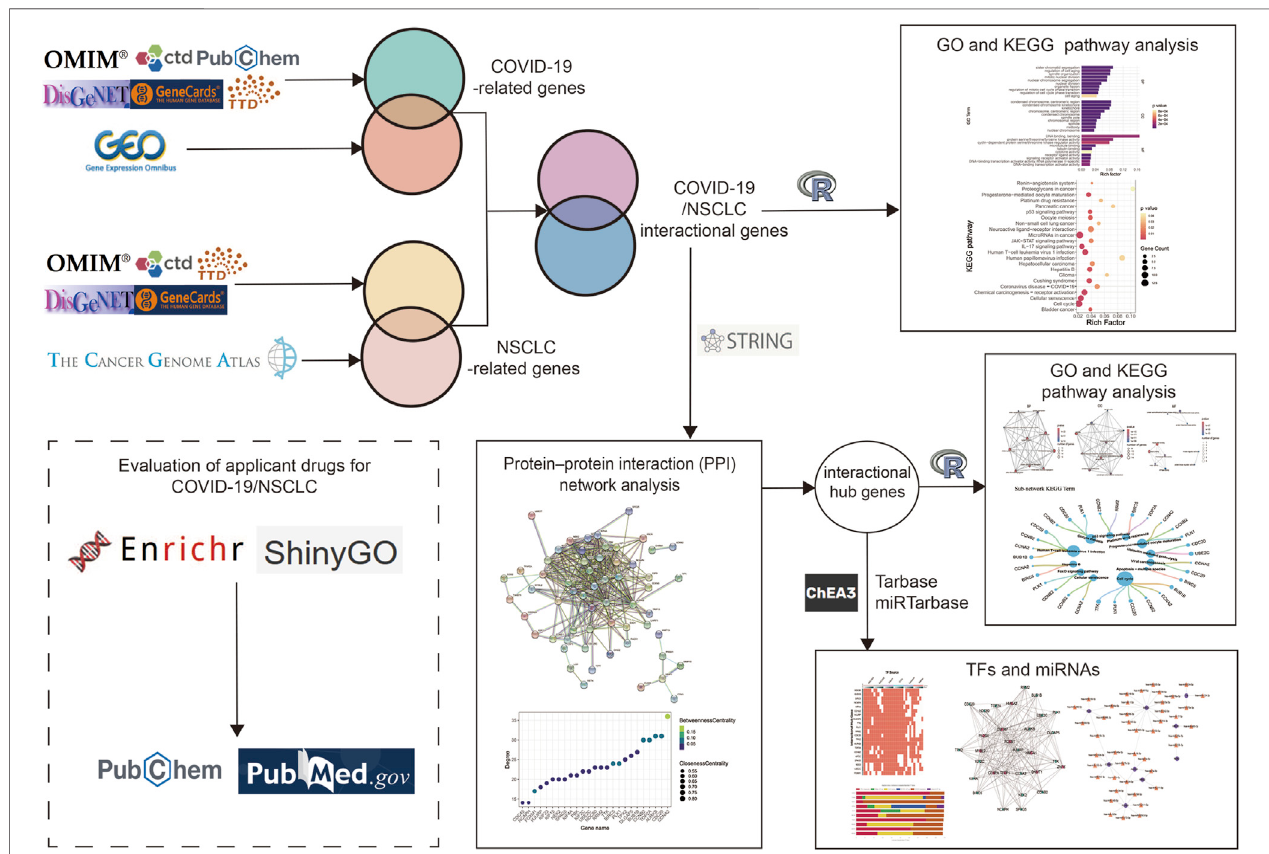
FIGURE 1 | Overview of the work fl ow of the present study.